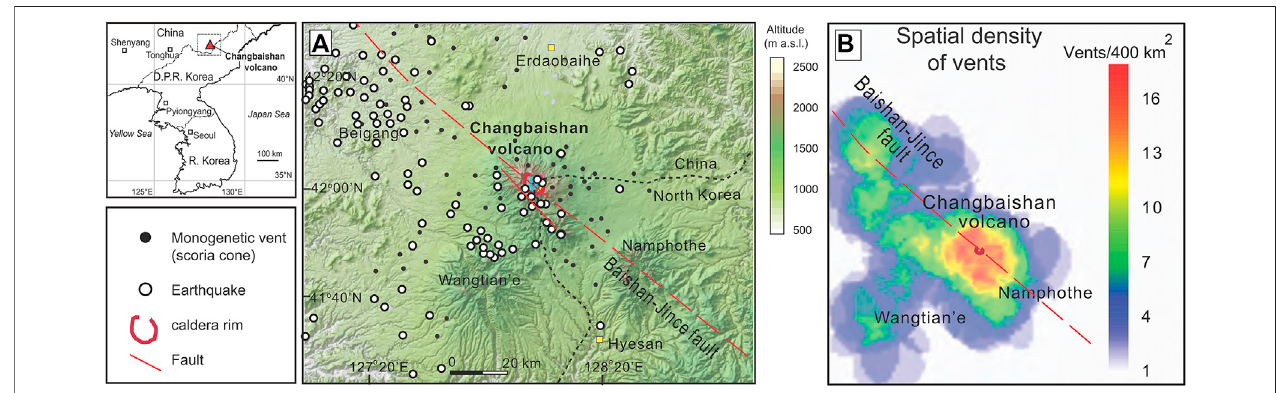
FIGURE 1 | Location map of the Changbaishan volcano (inset). (A) Simpli fi ed map of the main tectonic structures, earthquakes and vents in the Changbaishan area. The main structures and volcanic vent location are from Liu et al. (2004) and Zhang et al. (2018). Epicenters refer to earthquakes located by permanent seismic networks in the time interval 1977 – 2018 with M L between 0.8 and 4.4 (redrawn from Pan et al., 2021). (B) Spatial density of vents, mainly scoria cones, in the Changbaishan area.